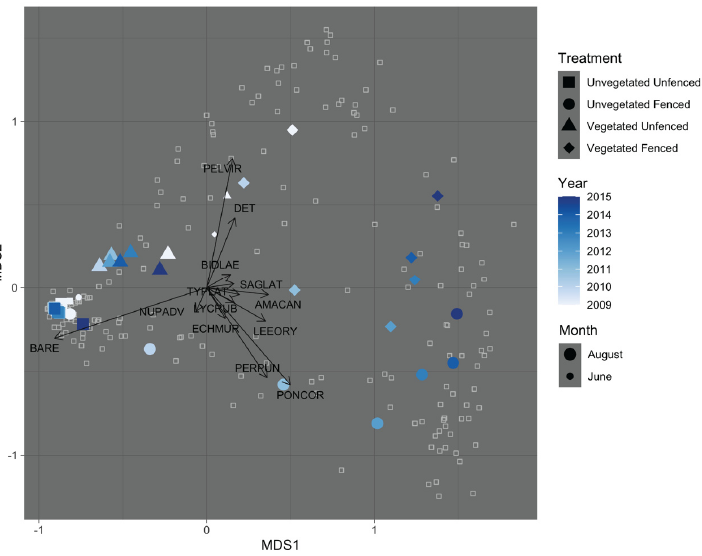
Figure 5. Ordination of the vegetation plots by non-metric multidimensional scaling (NMDS). June data is only included in 2009, as baseline data; all other years are August only. The June 2009 symbols are smaller; the June 2009 symbol for the Unvegetated Unfenced treatment is slightly more difficult to identify but can be found in the cloud of points located in the far left of the plot. Colored centroids symbolize the average position across each treatment and year combination. Hollow squares represent community composition of an individual plot in a single year. Vectors describe